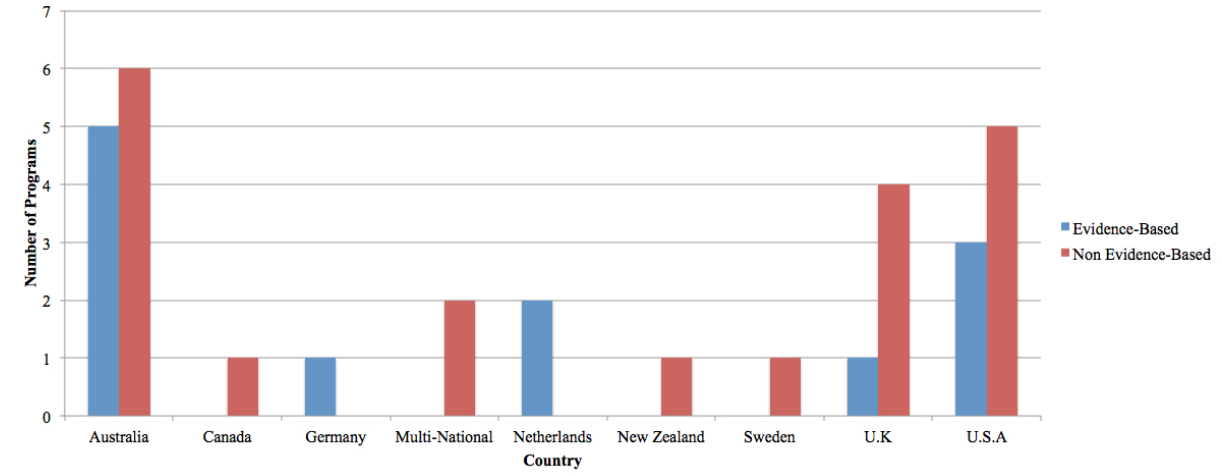
Figure 1. Program development by country of